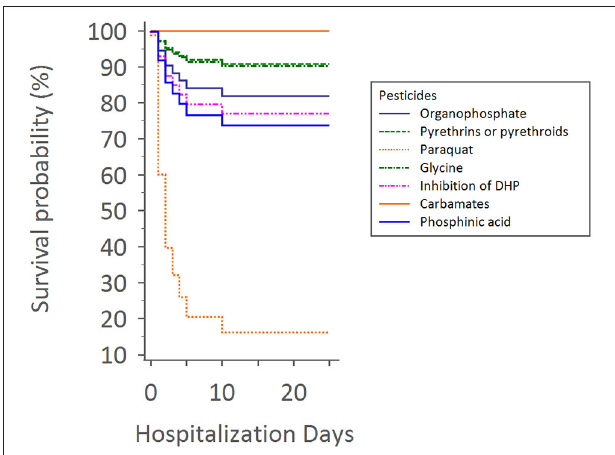
FIGURE 4 | Cox regression for survival analysis during hospitalization times with different pesticides.